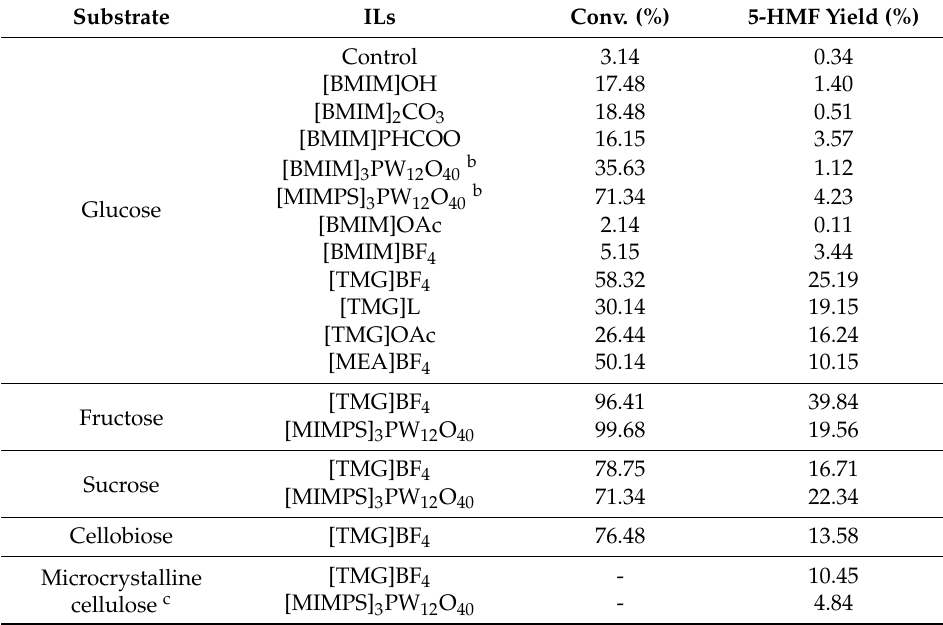
Table 1. Dehydration of carbohydrates with different ILs a